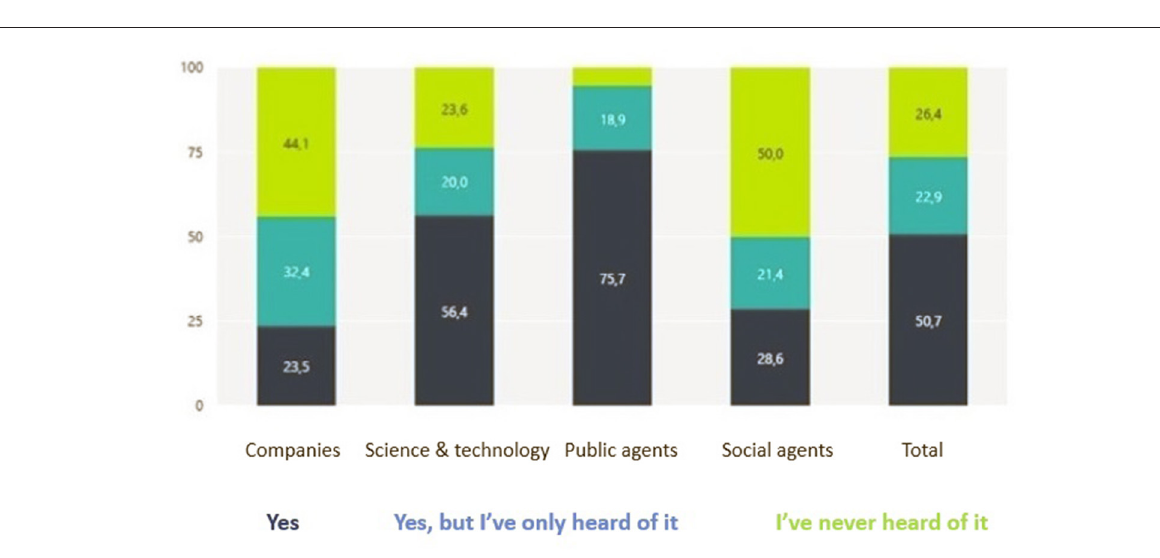
of Strategic Projects for Economic Recovery and